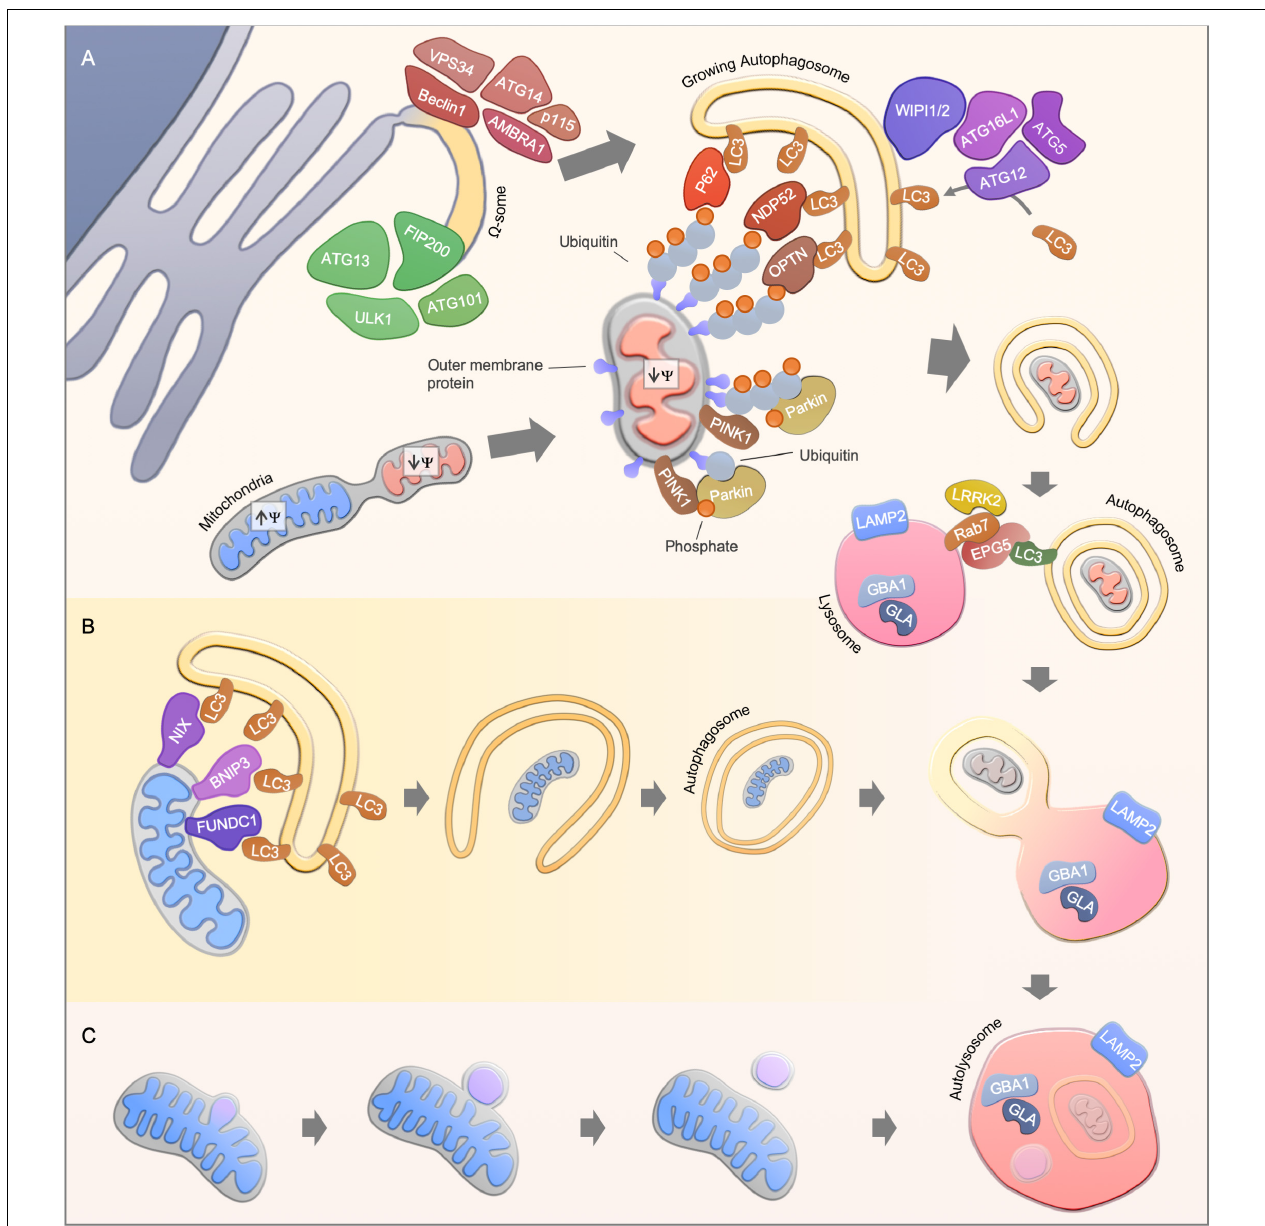
FIGURE 1 | Mitophagy pathways. (A) Ubiquitin-dependent PINK1/Parkin-mediated mitophagy. Upon mitochondrial damage, PINK1 is stabilized at the outer mitochondrial membrane, leading to Parkin activation and subsequent ubiquitination of mitochondrial proteins. Finally, autophagy receptors such as NDP52, OPTN, and p62 are recruited to mediate the engulfment of mitochondria by the autophagosomal membrane through the interaction with LC3. A possible source of the autophagosomal membrane is provided by the endoplasmic reticulum, where the autophagy core complexes VPS34 and ULK1 initiate the membrane formation. The membrane formation is further mediated by WIPI1 and WIPI2, leading to the recruitment of the ATG16L1-complex and LC3, thereby facilitating the formation of autophagosomes. Finally, autophagosomes fuses with acidic lysosomes, a step that is regulated by concerted action of autophagosomal and lysosomal proteins. (B) Ubiquitin-independent receptor-mediated mitophagy. Ubiquitin-independent receptor mediated mitophagy is mediated by the recruitment of autophagy receptor proteins such as NIX, BNIP3, and FUNDC1 to the mitochondrial membrane. The receptor proteins recruit LC3, which enables the engulfment of mitochondria by autophagosomes. (C) Alternative degradation pathways. Piecemeal mitophagy and mitochondrial-derived vesicle degradation are cellular pathways that mediate localized degradation of